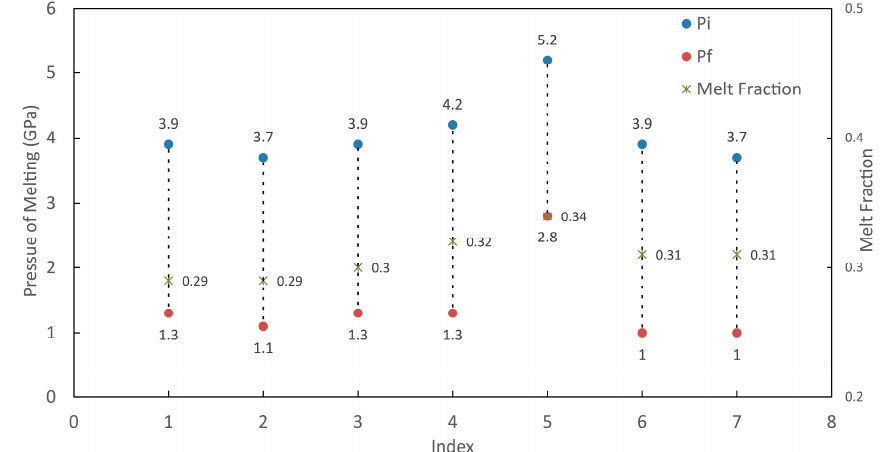
Figure 5. The pressures of initial and final melting of samples are calculated with the PRIMELT3 software [42]. Melt fraction ranges between 0.29 and 0.34. The horizontal axis shows the sample information, corresponding to the “index” row in Table 1. Pi—Pressure of initial melting, Pf—Pressure of final melting.